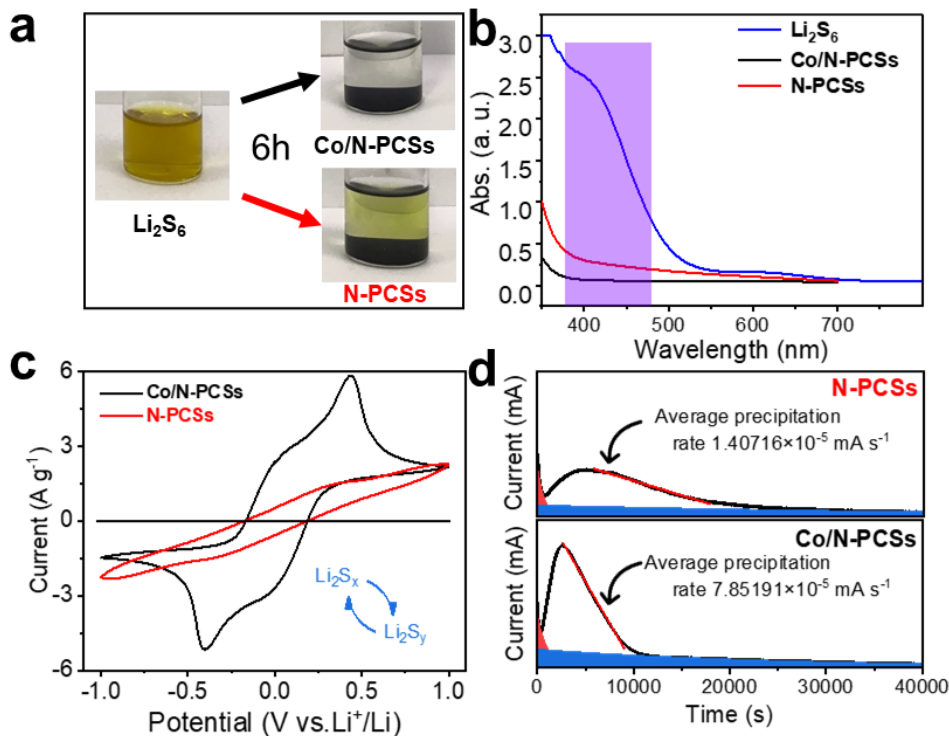
Figure 5. ( a ) N-PCSs and Co/N-PCSs adsorption capacity test in Li 2 S 6 solutions, ( b ) UV-vis adsorp- tion spectra of Li 2 S 6 solutions after 6 h. ( c ) CV curves of symmetric half-cells within − 1.0~1.0 V at a scan rate of 10 mV s -1 , ( d ) Potentiostatic discharge profiles at 2.14 V on N-PCSs and Co/N-PCSs.